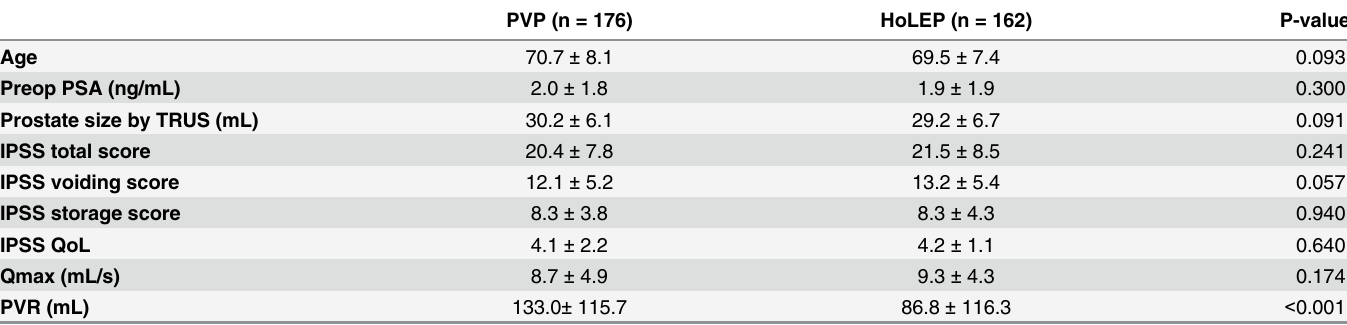
Table 1. Demographic characteristics.